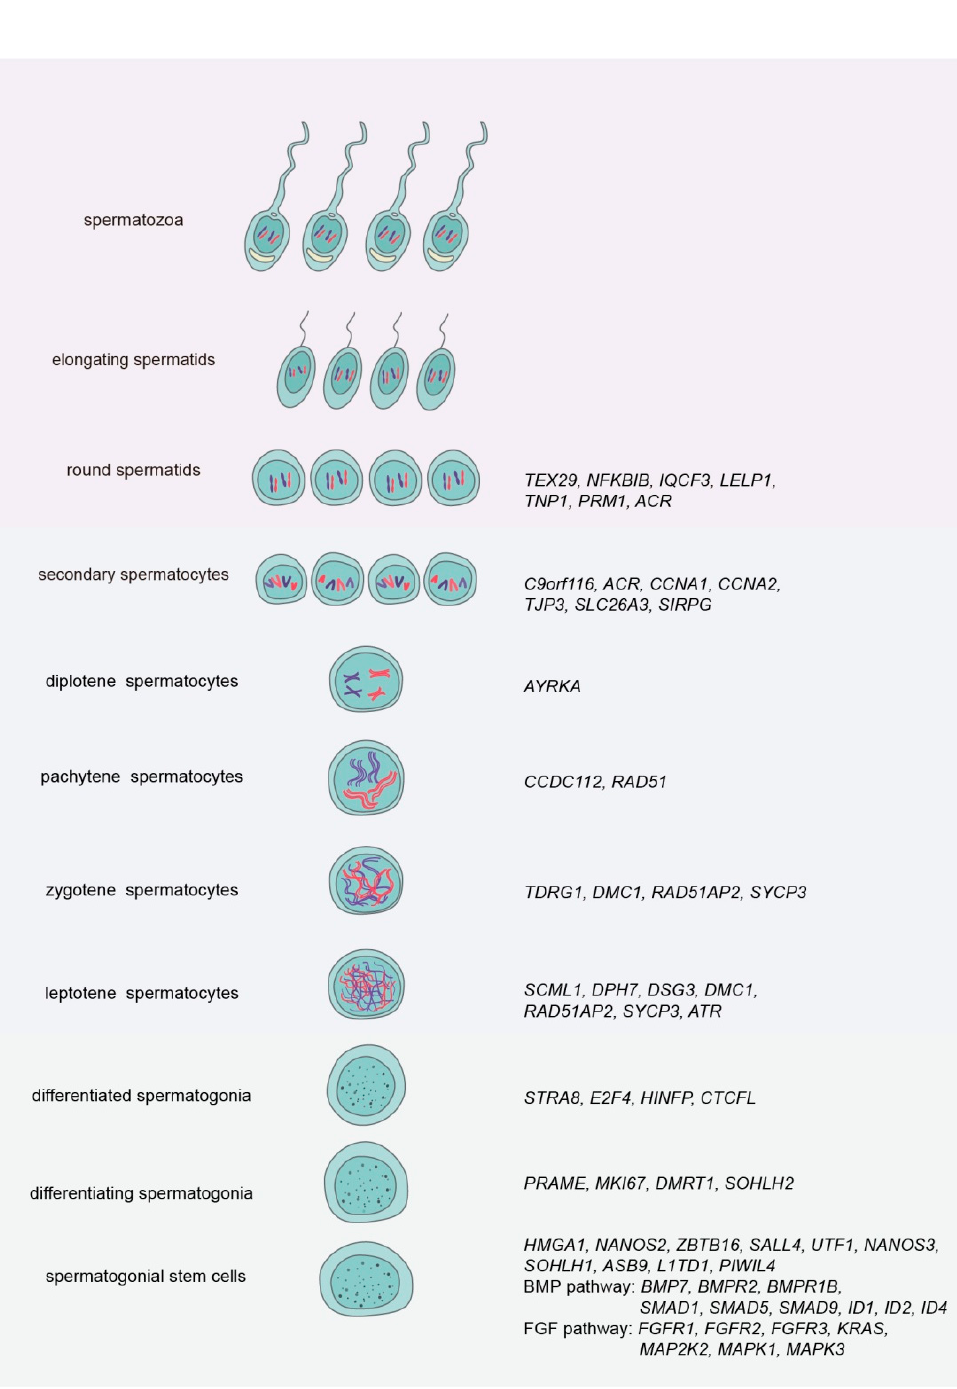
Figure 1. Expression of new genes in human spermatogenesis by single-cell RNA sequencing. Left and middle panels: the main types of human male germ cells; right panel: new genes and signaling pathways identified in each type of human male germ cells.